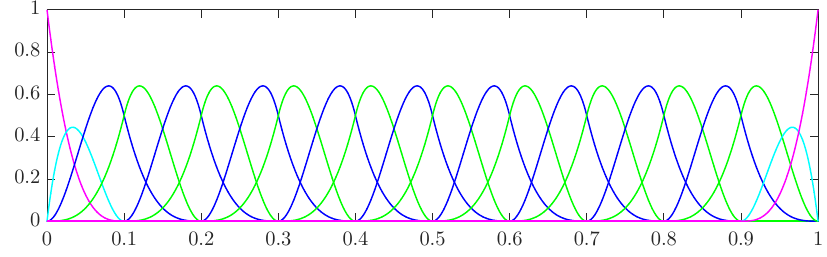
Figure 2. B-splines B 1, [ p , k ] , . . . , B n ( p − k )+ k + 1, [ p , k ] for p = 3 and k = 1, with n = 10.